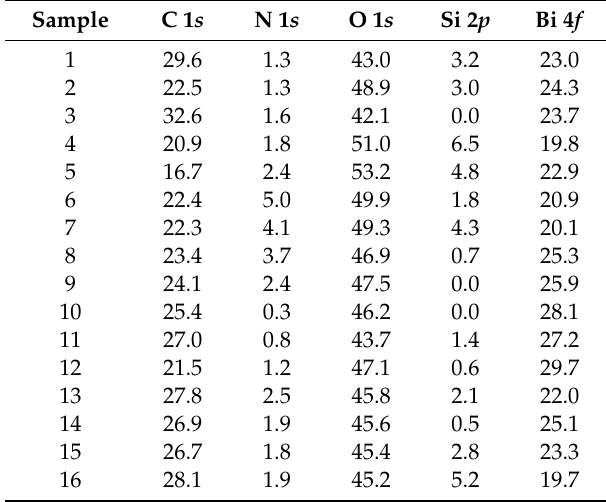
Table 1. Atomic concentration of the FS in